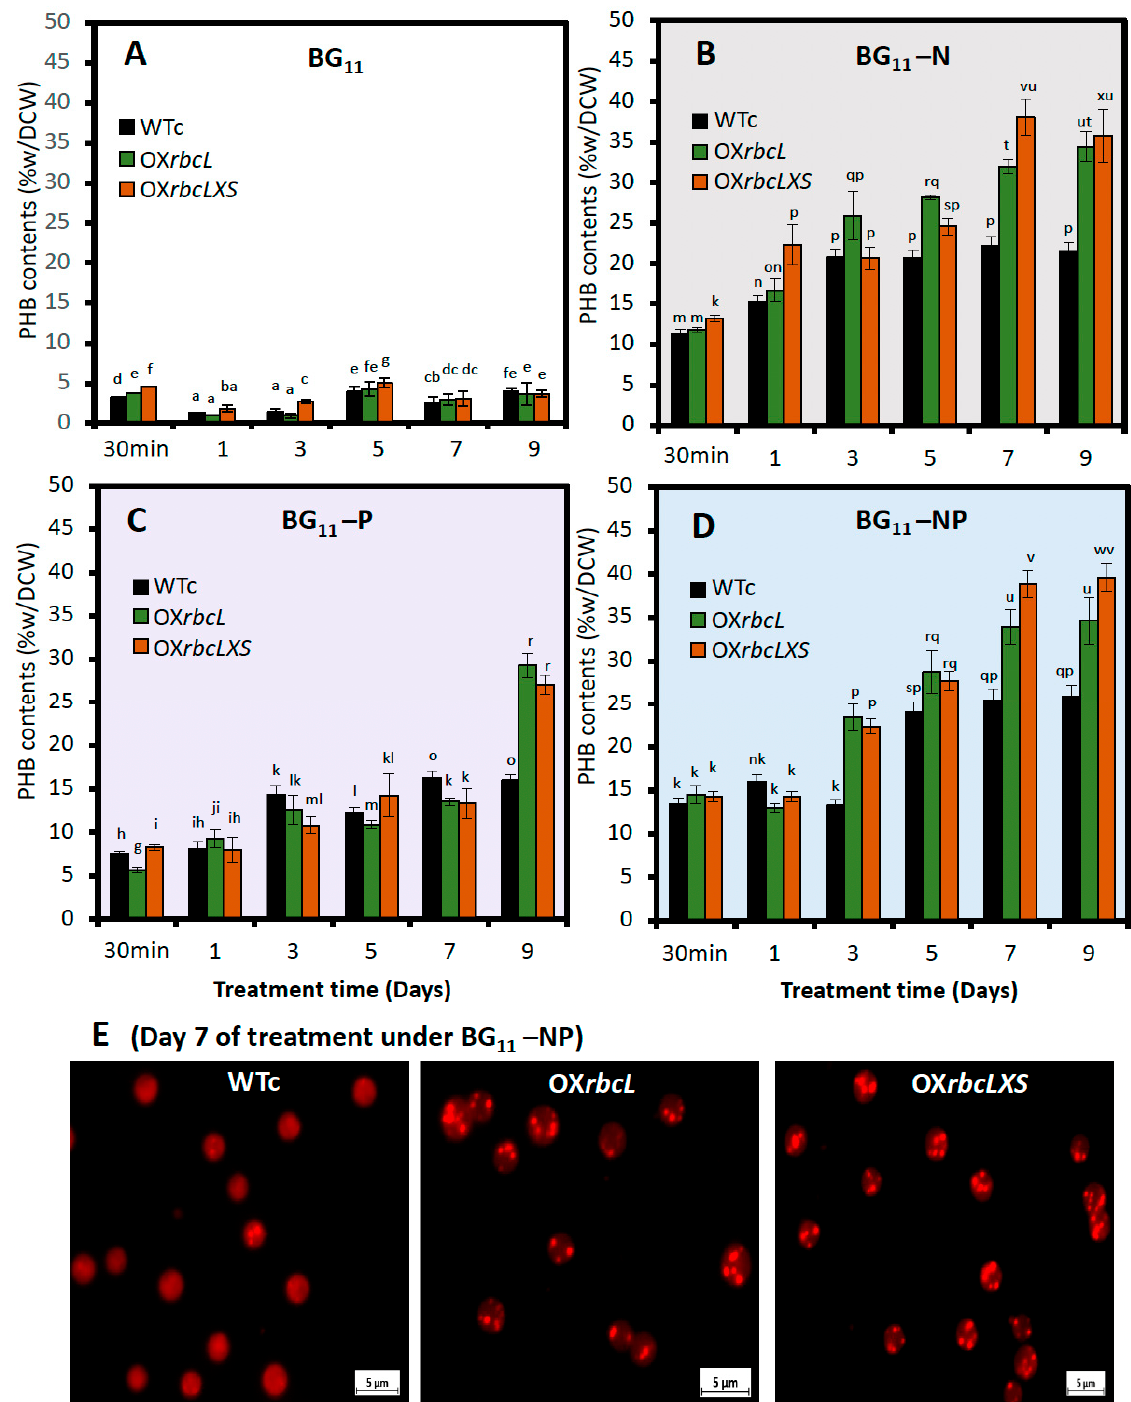
Figure 6. PHB contents of Synechocystis WTc, OX rbcL , and OX rbcLXS strains after adapting in ( A ) normal BG 11 medium, ( B ) BG 11 -N, ( C ) BG 11 -P, and ( D ) BG 11 -NP for 9 days. The error bars represent standard deviations of means (means ± S.D., n = 3). Means with the same letter are not significantly different with the significance level at p < 0.05. ( E ) The Nile red staining of neutral lipids, herein PHB granules, in all strains treated by BG 11 -NP condition for 7 days. The stained cells were visualized under fluorescent microscope with a magnification of ×100.